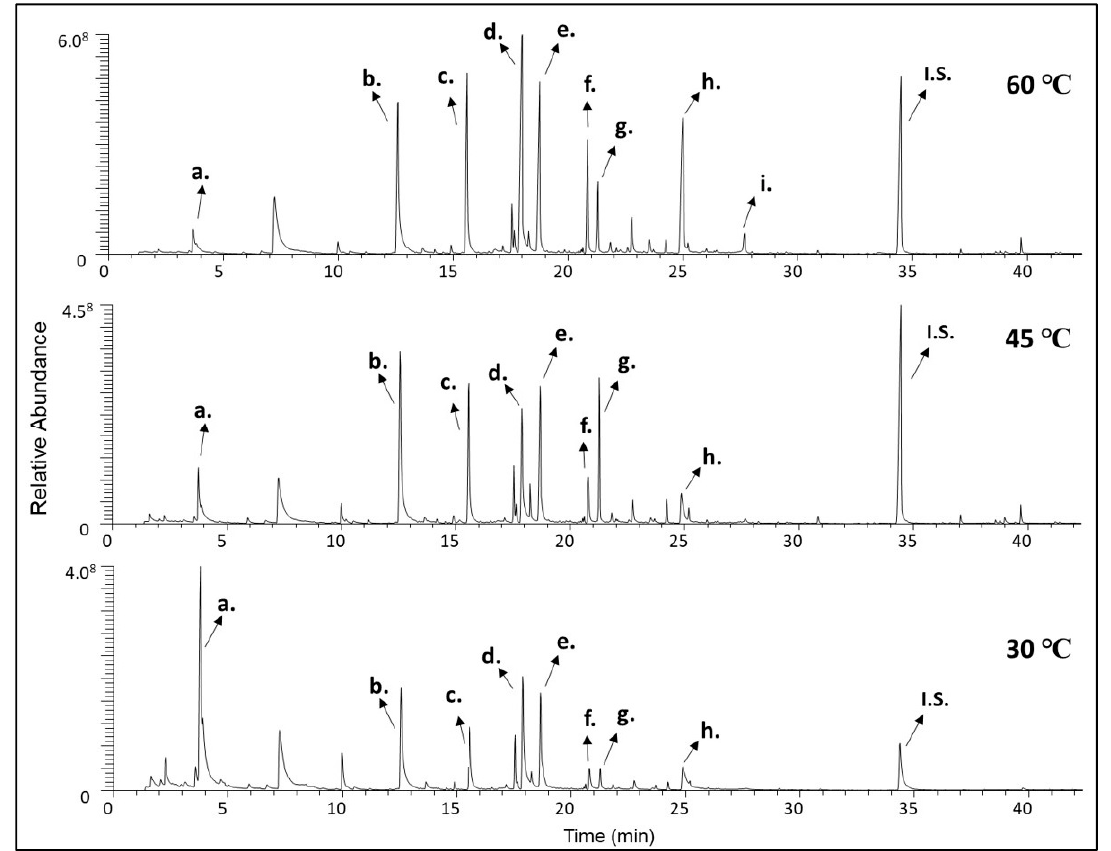
Figure 1. Characteristic chromatograms of the same sample from three representative different temperatures (30, 45, and 60 °C). (a) 3-methylbutanenitrile, (b) benzaldehyde, (c) 2-phenylacetaldehyde, (d) 2-phenylethan-1-ol, (e) 2-phenylacetonitrile, (f) 1-phenylbutane-2,3-dione, (g) methyl nonanoate, (h) 3-hydroxy-4-phenyl-2-butanone, (i) ( Z )-3-hydroxy-4-phenylbut-3-en-2-one, (I.S.) Internal Standard.